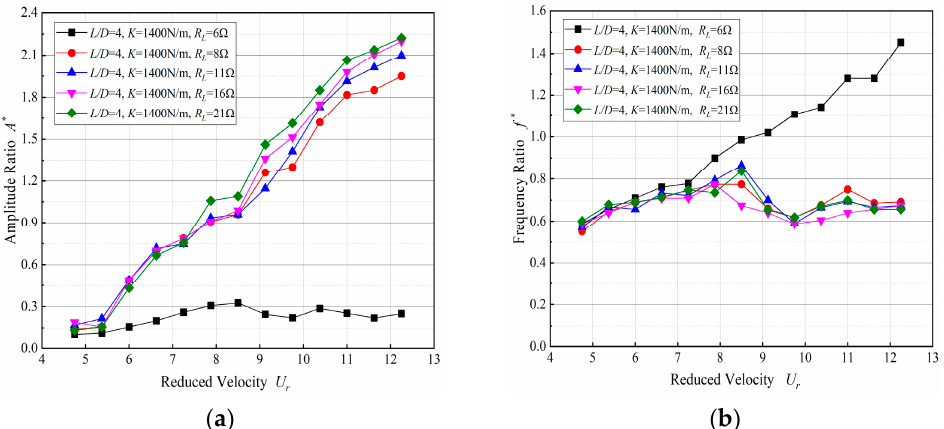
Figure 15. Amplitude ratio and frequency ratio for different load resistances ( L / D = 4). ( a ) Amplitude response; ( b ) Frequency response.